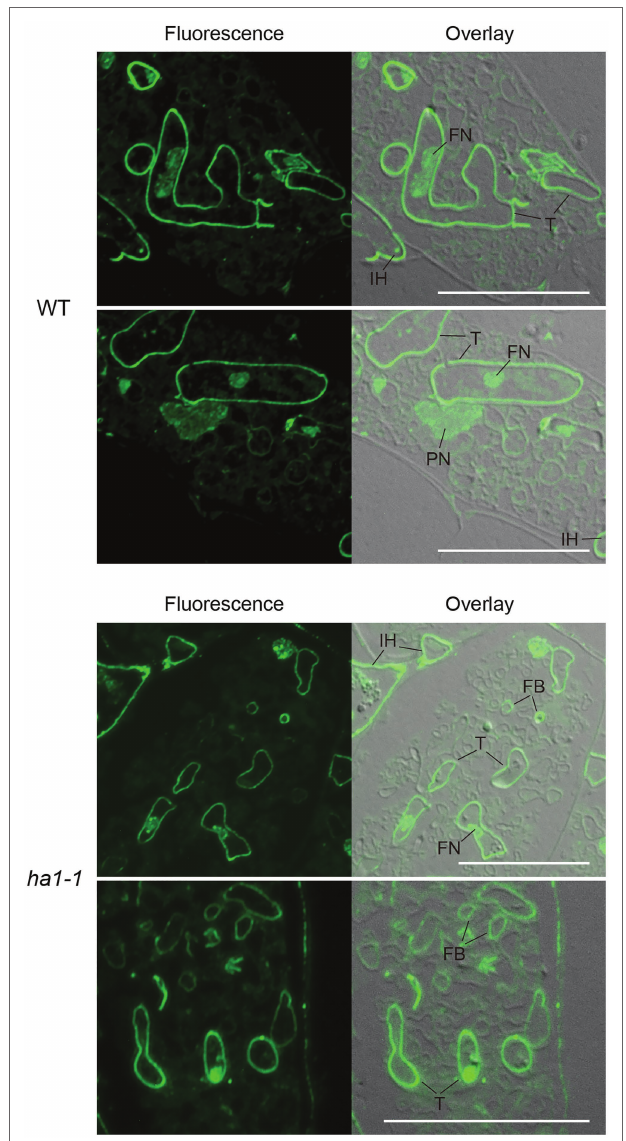
FIGURE 4 | Subcellular localization of polyP using polyphosphate (polyP) binding domain (PPBD) affinity labeling. Representative fluorescence images of polyP localization (left panels) and superimposed differential interference contrast (DIC) images (right panels) of arbuscule-containing cortical cells in wild-type and ha1-1 . Sections were incubated with a PPBD-anti-Xpress antibody complex and, subsequently, an anti-mouse IgG antibody conjugated with Alexa Fluor 488. An intense fluorescence signal was observed in cell walls of trunk hyphae and intraradical hyphae in both genotypes. Signals were sometimes detected in fine branches in the mutant. FB, fine branch; FN, fungal nucleus; IH, intraradical hypha; PN, plant nucleus; and T, trunk hypha. Scale bars = 20 μ